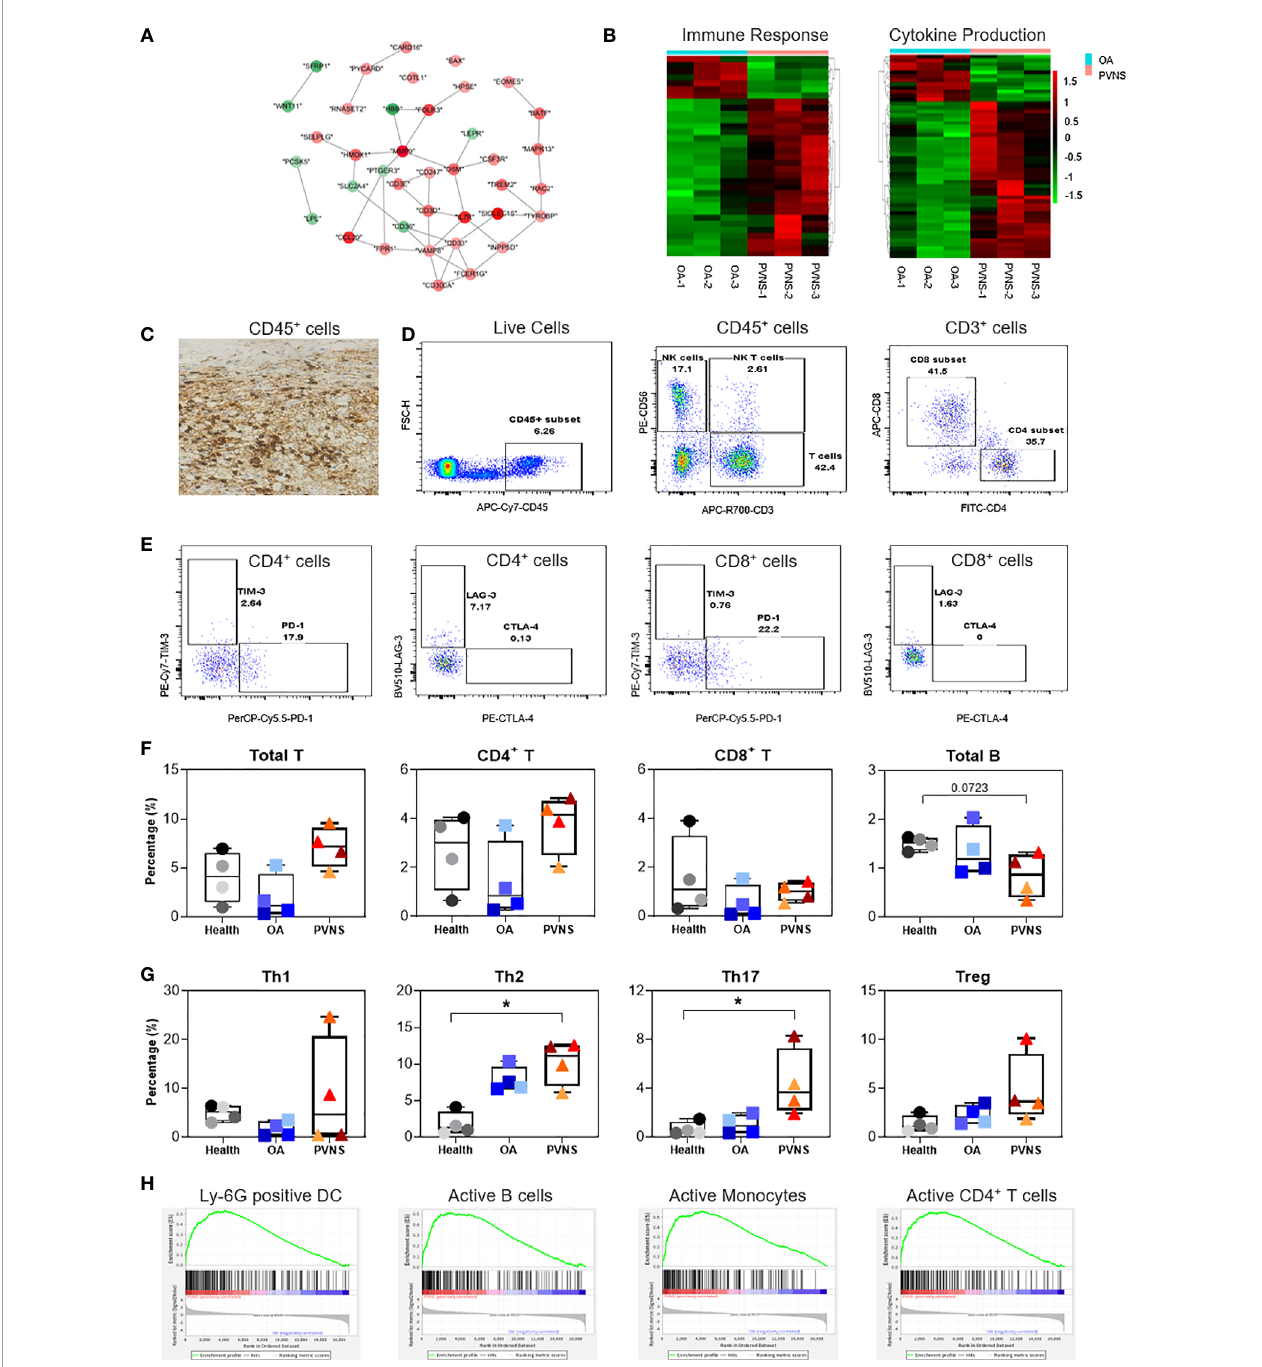
FIGURE 3 | Higher immune cell in fi ltration and increased cytokine secretion. (A) Differential gene expression data of immune response between pigmented villonodular synovitis (PVNS) and osteoarthritis (OA) patient samples were analyzed using cytoscape to identify the regulated subnetworks using known disease gene association. Nodes are colored to determine the fold change. (B) Heatmap showing the gene expression between PVNS and OA for immune response and cytokine production subnetwork. Fold change of representative differentially expressed genes (DEGs) were also shown. (C) Immunohistochemical staining with CD45 speci fi c antibody (scale bar: 100 µM). (D, E) Gating of fl ow cytometric analysis of CD45 + in fl ammatory cell populations in PVNS synovium. (F, G) The percentage of total T cell, CD4 + T cell, and CD8 + T cell, Treg (CD4 + CD25 + CD127 − ), Th1 (CD4 + CCR7 − CXCR3 + ), Th2 (CD4 + CCR7 − CCR5 + ), and Th17 (CD4 + CCR7 − CCR6 + ) in synovium from healthy subjects (n=4), OA patients (n=4), and PVNS patients (n=4). One-way ANOVA (Druskal-Wallis test) was applied to the multiple comparisons. * p -value< 0.05. (H) Gene set enrichment analysis plot depicting the enrichment of DEGs in Ly-6G, active B cells, active monocytes, and active CD4 + T cells in PVNS